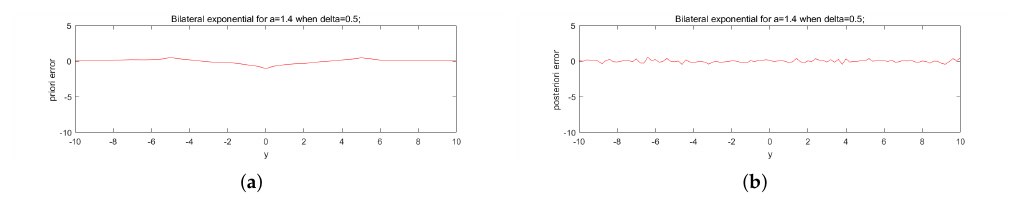
Figure 9. ( a ) A priori error. ( b ) A posteriori error. The errors of b ( x ) when δ = 0.5, α = 1.4.